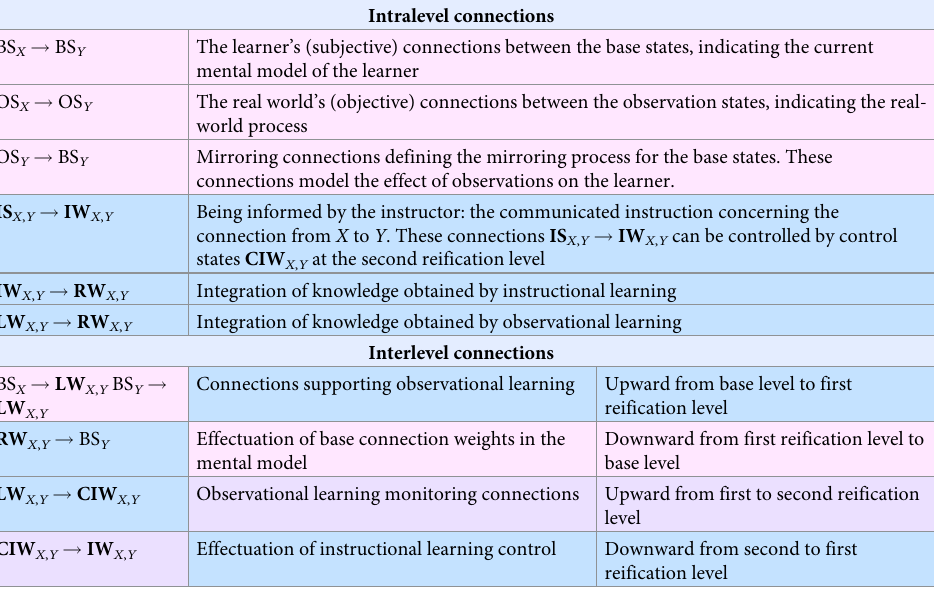
Table 2. Types of connections in the introduced adaptive network architecture.